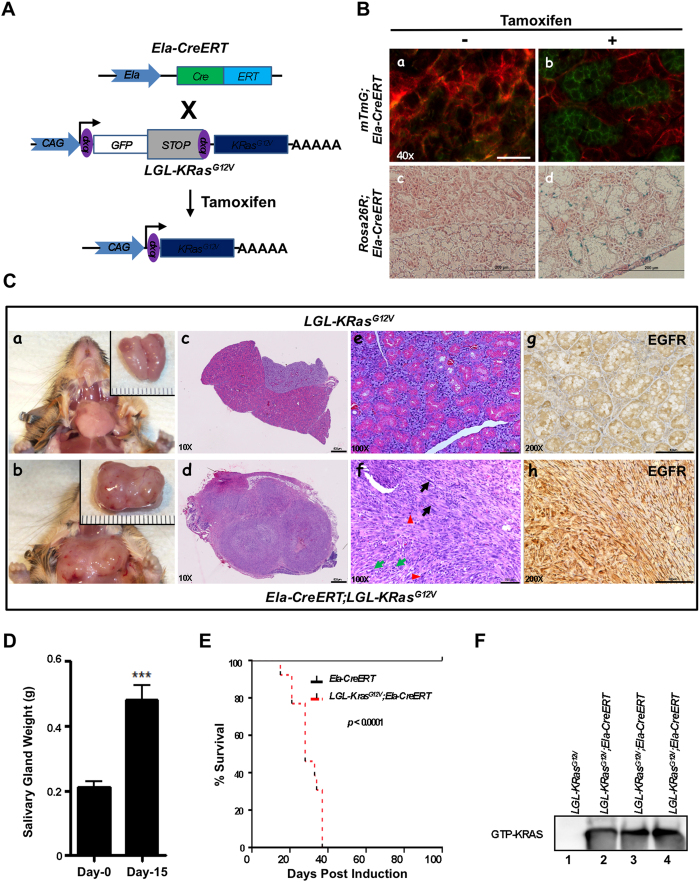
Elastase I-driven oncogenic KRASG12V expression induces SDC-like tumors in the SMGs.(A) The diagram of the Ela-CreERT and LGL-KRasG12V transgenes2630. Expression of the TAM-inducible Cre recombinase (CreERT) is driven by elastase I promoter/enhancer. KRASG12V expression is blocked by a loxP-GFP-Stop-loxP cassette (LGL). A mouse BAC of 222-kb carrying the intact elastase I gene was used to provide the endogenous native context of elastase I gene26. CreERT removes STOP cassette (LGL) through recombination, allowing the KRASG12V expression. (B) Elastase I-driven recombination in mTmG and Rosa26R reporter mice ascertains ductal original. Green fluorescence was exclusively detected in the ductal cells of mTmG;Ela-CreERT reporter mice after vehicle (panel a) or TAM-feeding (panel b). Scale bar: 50 μm (panel a). β-galactosidase activity was observed in the SMG ductal cells of Rosa26R;Ela-CreERT mice after TAM-feeding (panel d) compared to control mice (panel c). Scale bar: 200 μm. (C) Characterization of SMGs of LGL-KRasG12V;Ela-CreERT mice on day-24 post TAM-feeding. Gross anatomy revealed large ventrolateral cervical masses in SMGs of LGL-KRasG12V;Ela-CreERT mice on day-24 (panel b). H&E and immunohistochemical (IHC) staining showed the microscopic abnormalities in the SMGs of TAM-fed LGL-KRasG12V;Ela-CreERT mice on day-24 (panels d, f, h). Scale bars: 800 μm (in panels c and d); 100 μm (panels e–h). (D) Wet weight of SMG from LGL-KRasG12V;Ela-CreERT mice at 15-days post TAM-feeding (n = 13) or not (n = 7). ***p < 0.001. (E) Overall survival of mice after KRASG12V induction is drastically reduced. Percent survival of Ela-CreERT versus LGL-KRasG12V;Ela-CreERT mice after TAM administration. Median survival of LGL-KRasG12V;Ela-CreERT mice was 28-days. n = 13 per group; p < 0.0001 by Log-rank (Mantel-Cox) test. (F) KRASG12V is activated in the SMG tumors of LGL-KRasG12V;Ela-CreERT mice following TAM-gavage. Transgenic mice of indicated genotypes were gavaged with TAM. SMG samples were harvested on day-24 and whole tissue lysates (1 mg) from each sample were pulled down with Raf-1 RBD agarose beads. Pulldown reactions were resolved by SDS-PAGE (12%) and Western blotting was performed with an anti-KRAS antibody to detect active (GTP-bound) KRASG12V.